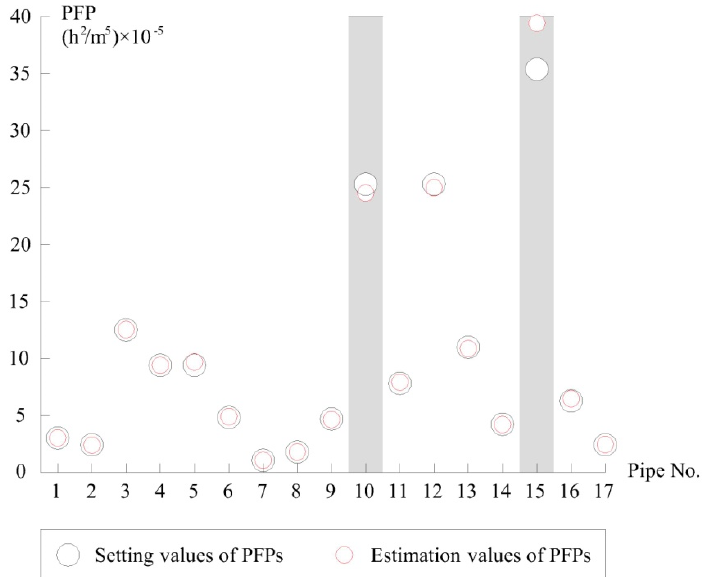
Figure 4. Estimation results of PFPs in the simple actual HN.